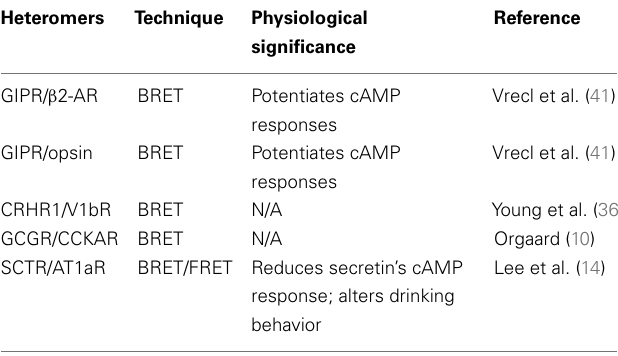
Table 2 | Oligomerization of inter-family family B GPCRs